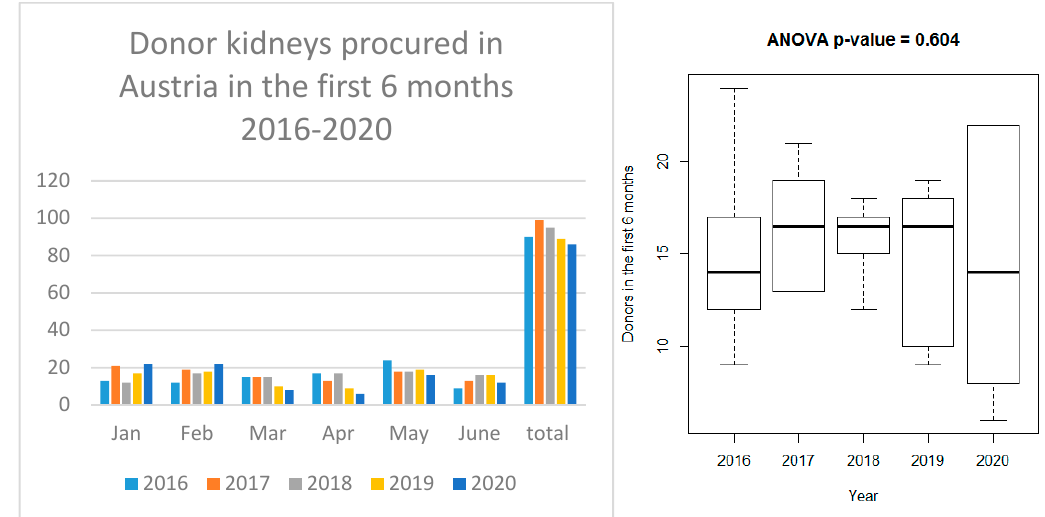
Figure 2. Monthly number of procured kidneys in Austria during the COVID ‐ 19 pandemic (January to June 2020) and comparison of the monthly average in previous years by ANOVA (data from the four Austrian transplant centers in Vienna, Innsbruck, Graz and Linz).